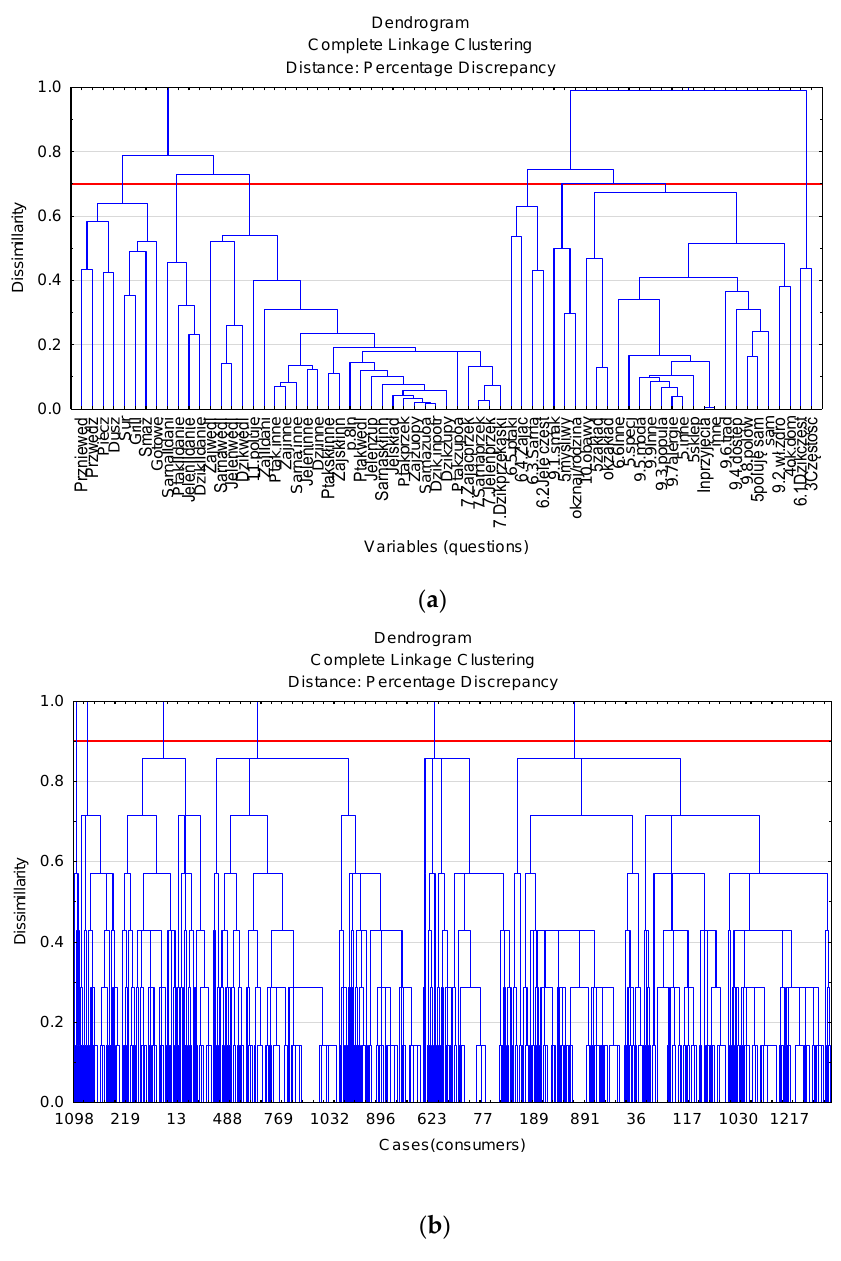
Figure 1. Results of agglomeration of cluster analysis for variables ( a ) and cases ( b ). The dimensions described in this way were used to divide the respondents into Using the k-means method, the respondents were finally divided into six clusters. Medians calculated for previously constructed dimensions and sociodemographic varia- bles were used to describe the respondents in the clusters (Table 4). Table 4. Medians of dimensions describing the behavior of respondents and sociodemographic var- iables in the proposed clusters.